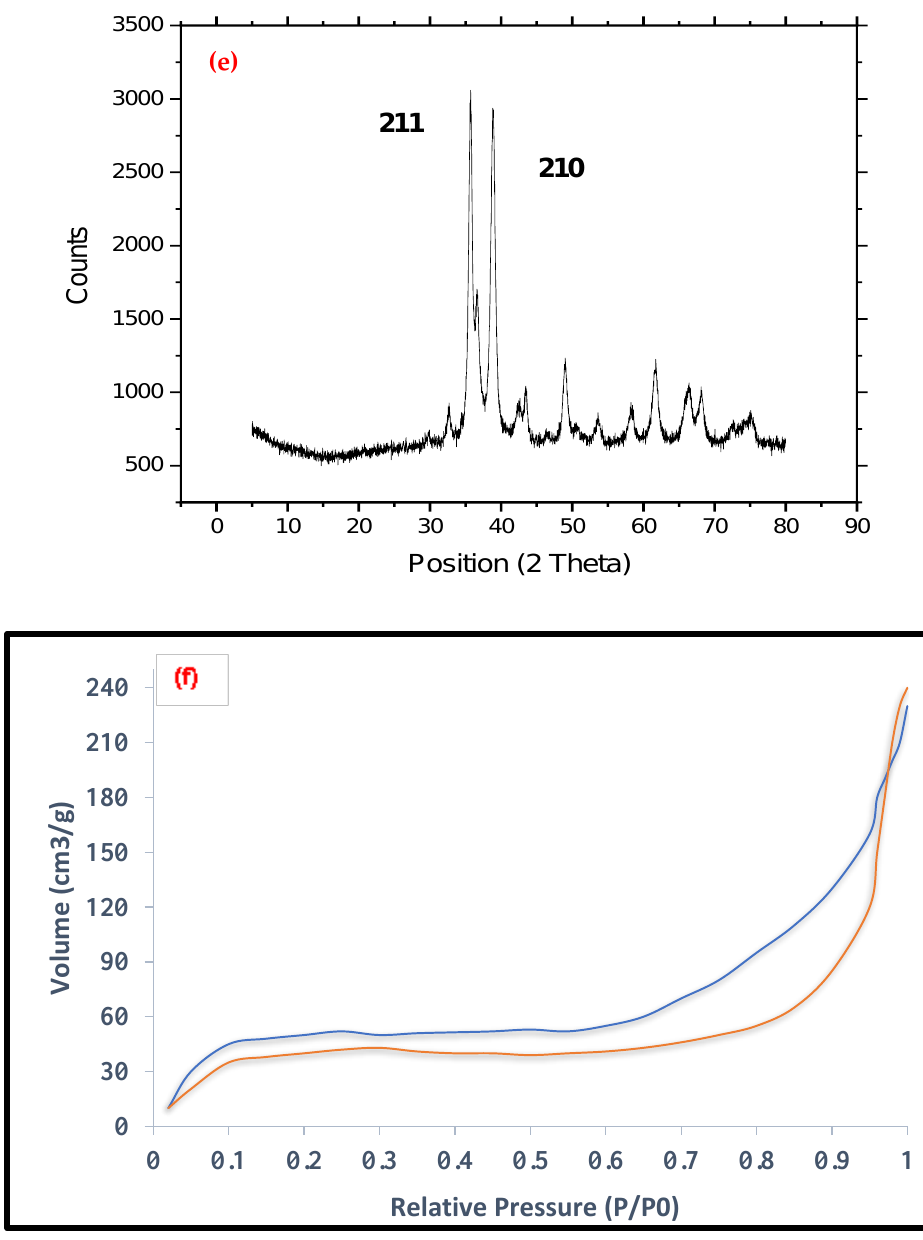
Figure 1. ( a ) SEM image at 400 nm for size, ( b ) SEM image at high low magnification, ( c ) TEM image, ( d ) EDX spectra, ( e ) XRD spectrum, and ( f ) adsorption-desorption isotherm curve for nitrogen of